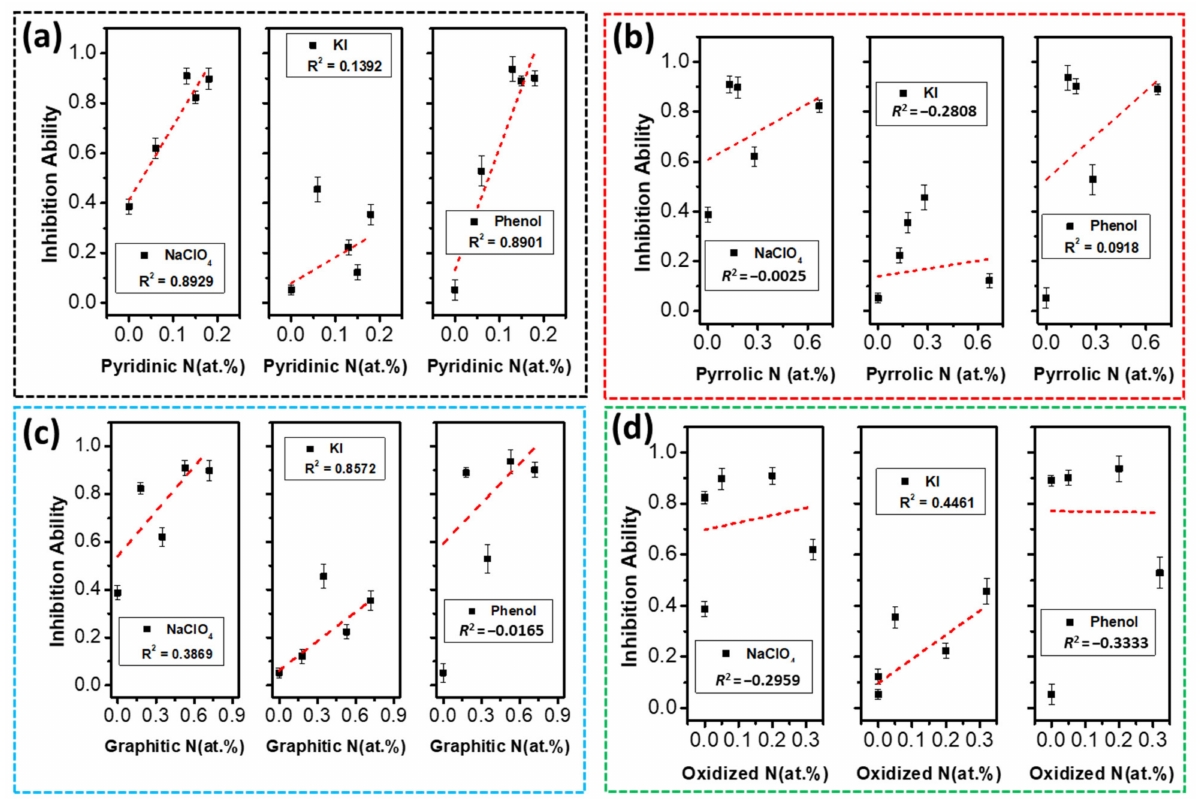
Figure 7. Role of non-radical (free electrons, surface-bound • OH and SO 4 • − radicals and surface- bound activated complexes) quenchers on ACP degradation ( k 1 (ACP)). Correlation between k 1 (ACP) and pyridinic N ( a ), k 1 (ACP) and pyrrolic N ( b ), k 1 (ACP) and graphitic N ( c ), and k 1 (ACP) and oxidized N ( d ). Quenching studies were carried out at C ACP = 10 mg L − 1 , C Catalyst = 100 mg L − 1 , C PMS = 0.5 mM, C FFA = C L-His = 50